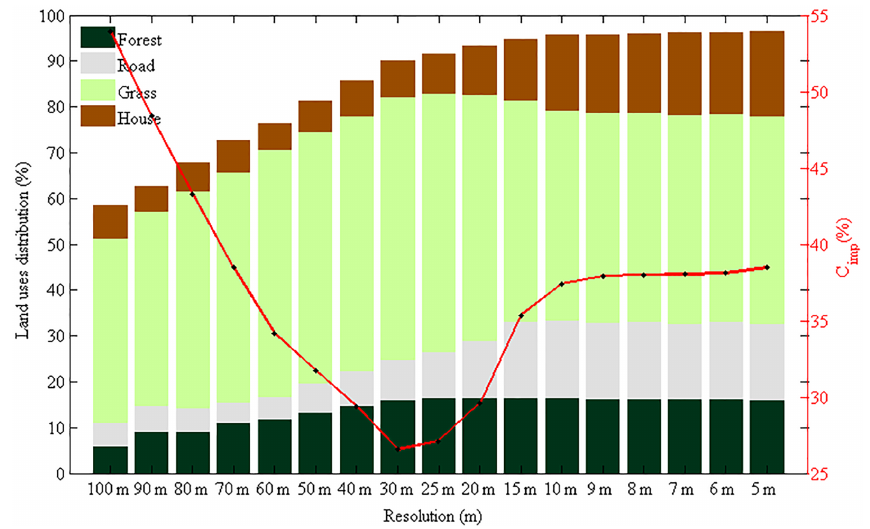
Figure 13. Scale dependence observed in the overall distribution of land cover classes and the imperviousness coefficient C imp with majority rule as explained in Fig.